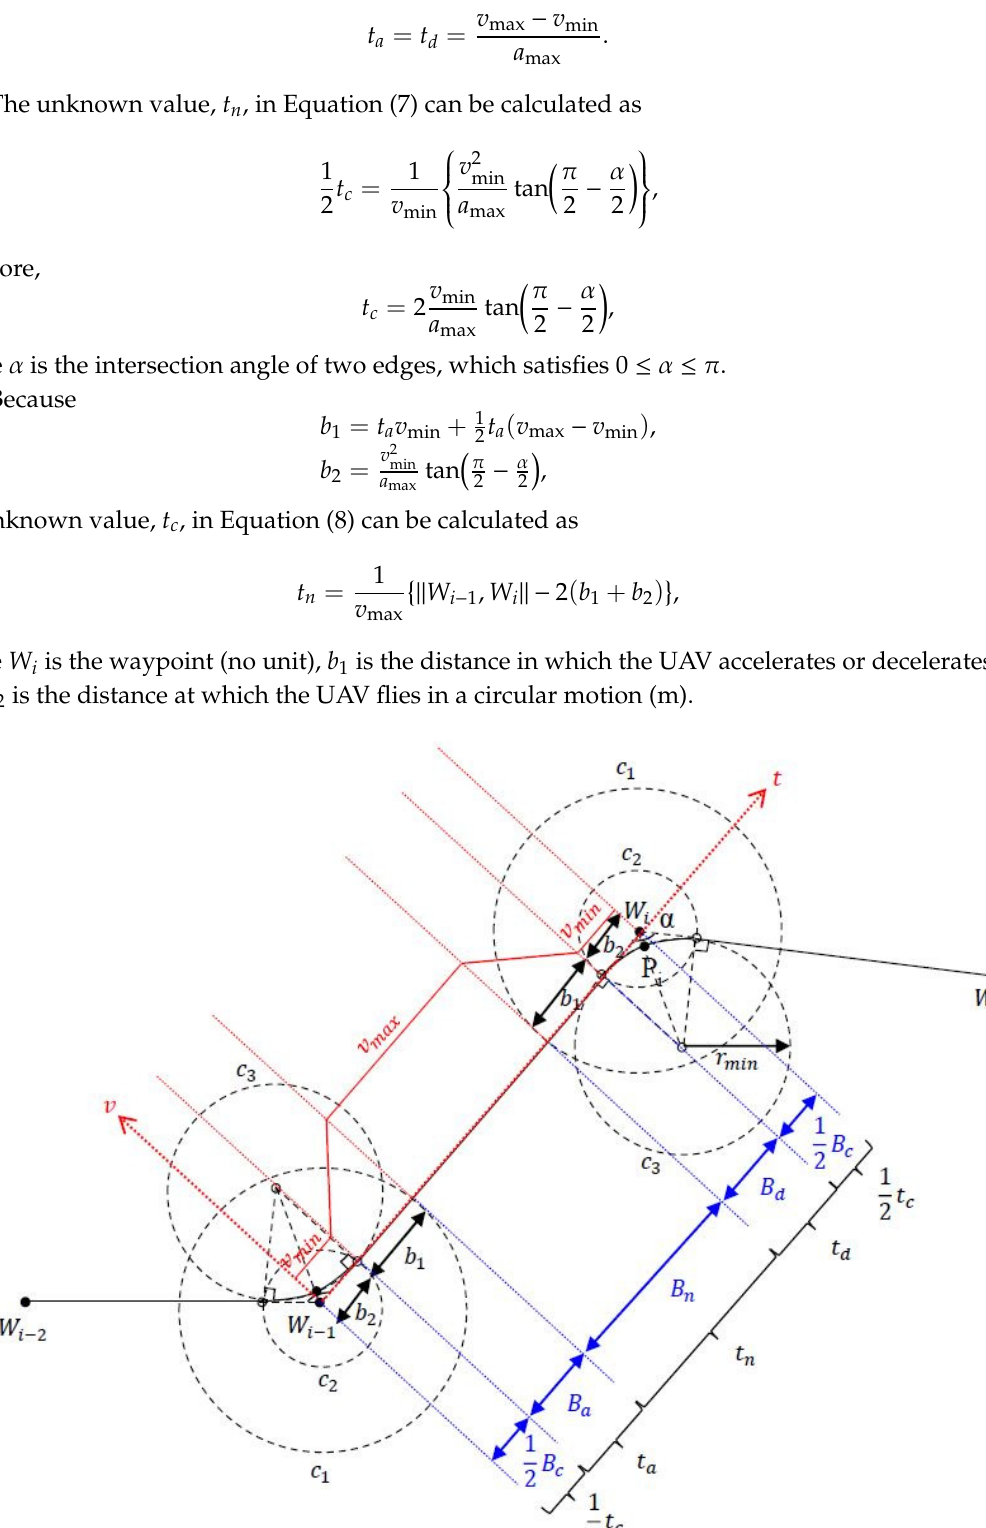
Figure 5. Flowchart of the energy-efficient path planning (EEPP) algorithm. 4. Mathematical Modeling of the UAV and Battery Pack 4.1. UAV The configuration and governing control inputs of the quadrotor are described in Figure 6, where 𝑋 (cid:3006) , 𝑌 (cid:3006) , and 𝑍 (cid:3006) represent earth coordinates, 𝑥 (cid:3044) , 𝑦 (cid:3044) , and 𝑧 (cid:3044) represent quadrotor coordinates, and 𝐹 (cid:3036) represents a thrust force generated by the i- th rotor in the indicated direction.